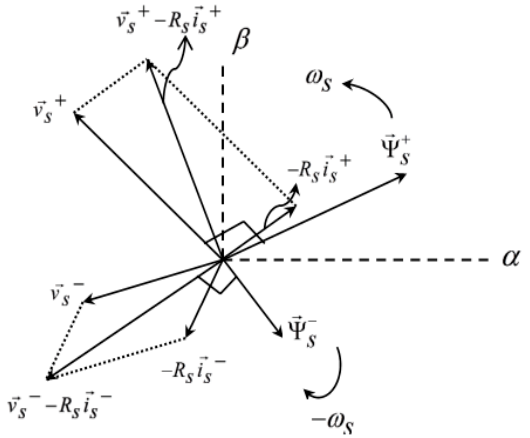
Figure 12. Relationship between fluxes, voltage, and current vectors of stator.